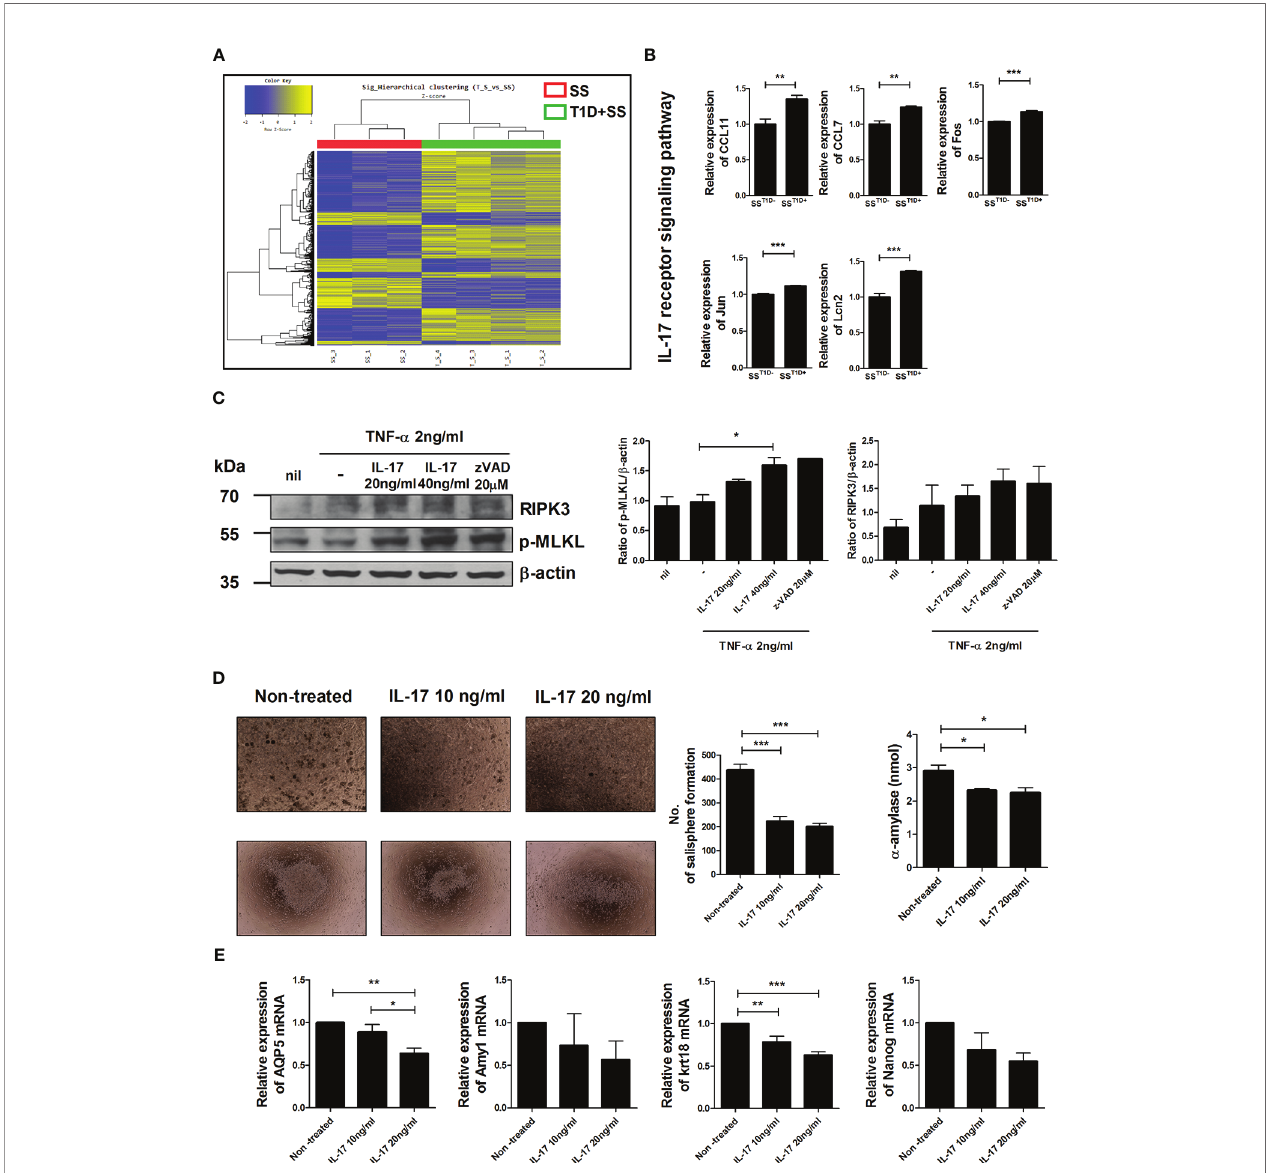
FIGURE 2 | Effects of IL-17 in salivary gland cells. (A) Hierarchical clustering shows gene expression in isolated salivary gland cells from NOD/ShiLtJ mice with or without T1D. Yellow and blue regions in cells indicate high and low relative expression levels, respectively. (B) Bar graphs show expression levels of indicated genes involved in the IL-17 receptor signaling pathway according to microarray analysis. (C) Human salivary gland cells were cultured with TNF- a in the absence or presence of recombinant human IL-17 or z-VAD for 48 h, and the expression levels of p-MLKL (left), RIPK3 (right), and b -actin were examined by Western blotting. Bar graphs show average expression levels of p-MLKL (left) and RIPK3 (right). (D) Micrographs show mouse salisphere sizes in cultured salivary gland stem cells (SGSCs) with IL-17. Original magni fi cations were 200× (top) and 40× (bottom). Bar graphs show average numbers of salispheres (left) and average secretion of a -amylase (right) under the indicated conditions. (E) Bar graphs show average transcription levels of AQP5 , Amy1 , Krt18 , and Nanog under the indicated conditions. Values are means ± SEM from three independent experiments. * p < 0.05, ** p < 0.01, *** p <